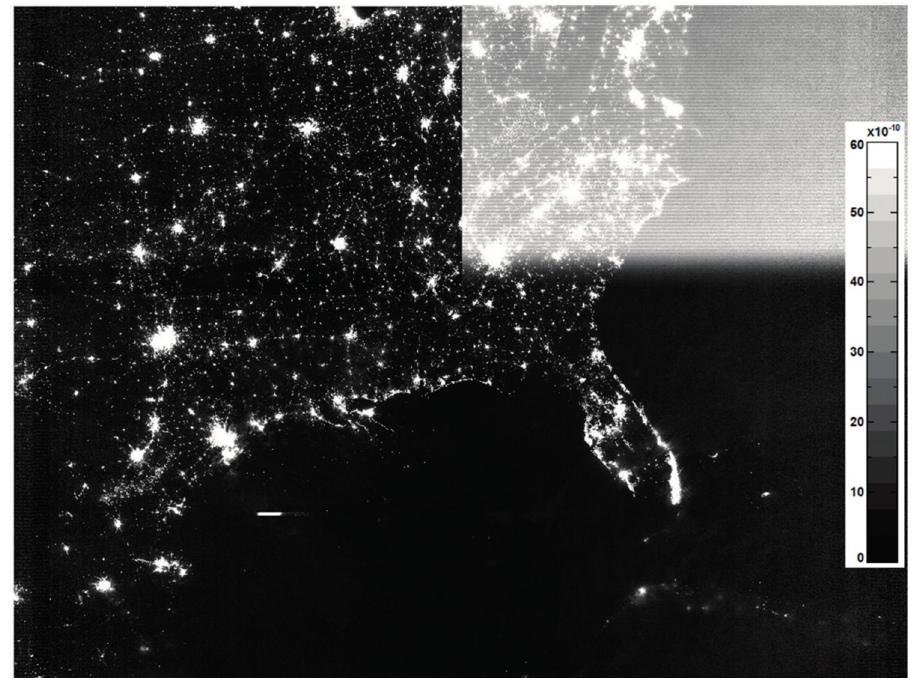
Figure 12. An example of Northern Hemisphere DNB SDR image before and after applying stray light correction. The image was taken on 19 June 2012, 07:27 UTC. The legend is in units of W·cm − 2 ·sr − 1